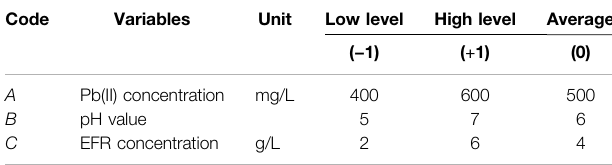
TABLE 1 | Variables value design of response surface.